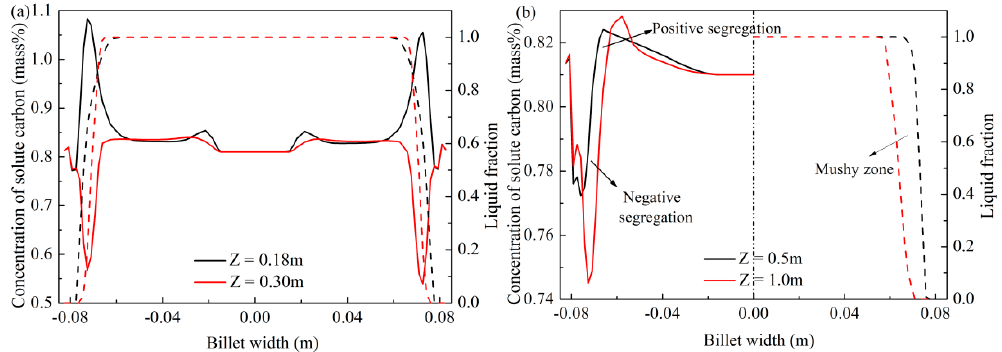
Figure 9. Predicted profiles for the concentration of solute C and liquid fraction: ( a ) Z = 0.18 and 0.30 m; and ( b ) Z = 0.5 and 1.0 m.